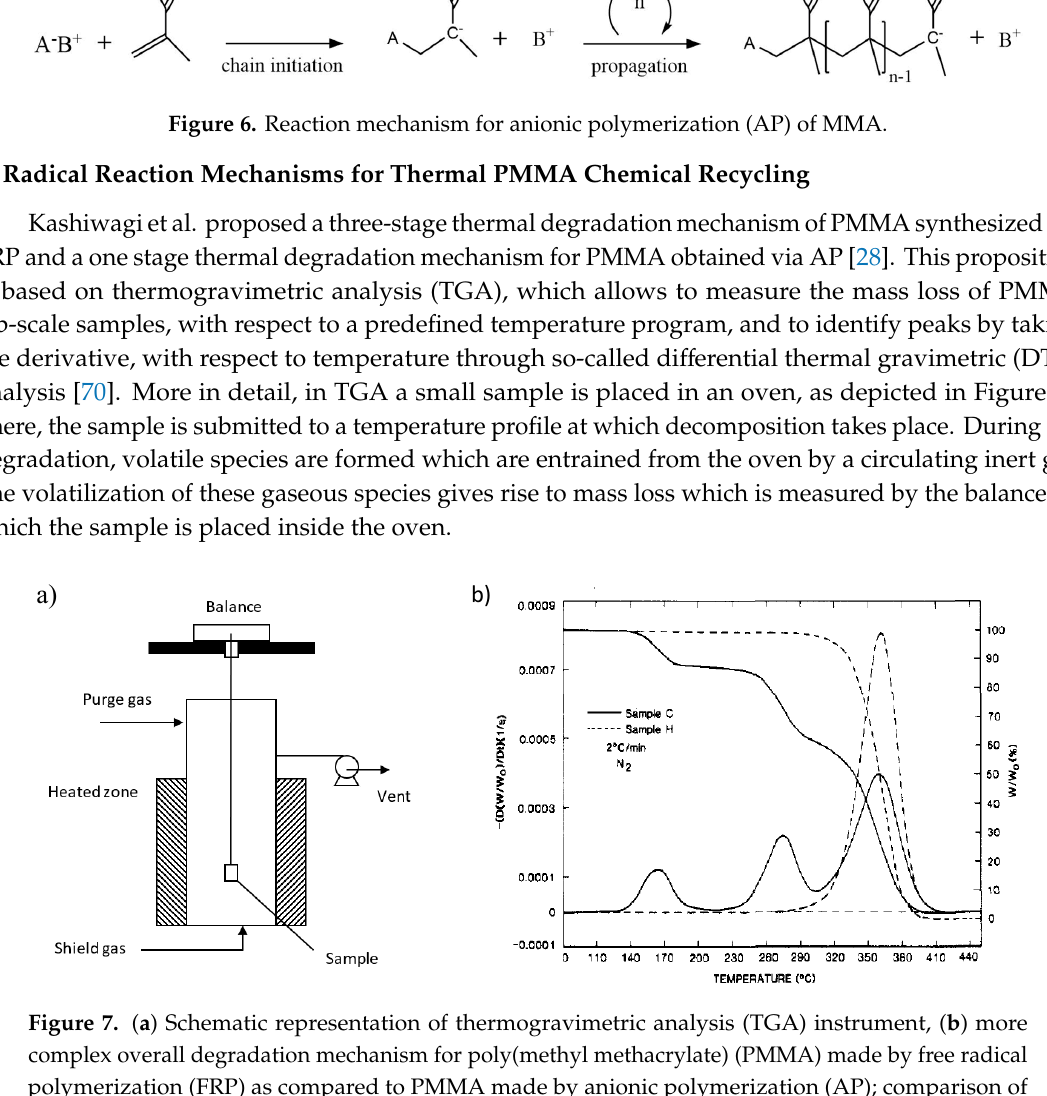
Figure 6 . Reaction mechanism for anionic polymerization (AP) of MMA. Figure 6. Reaction mechanism for anionic polymerization (AP) of MMA.